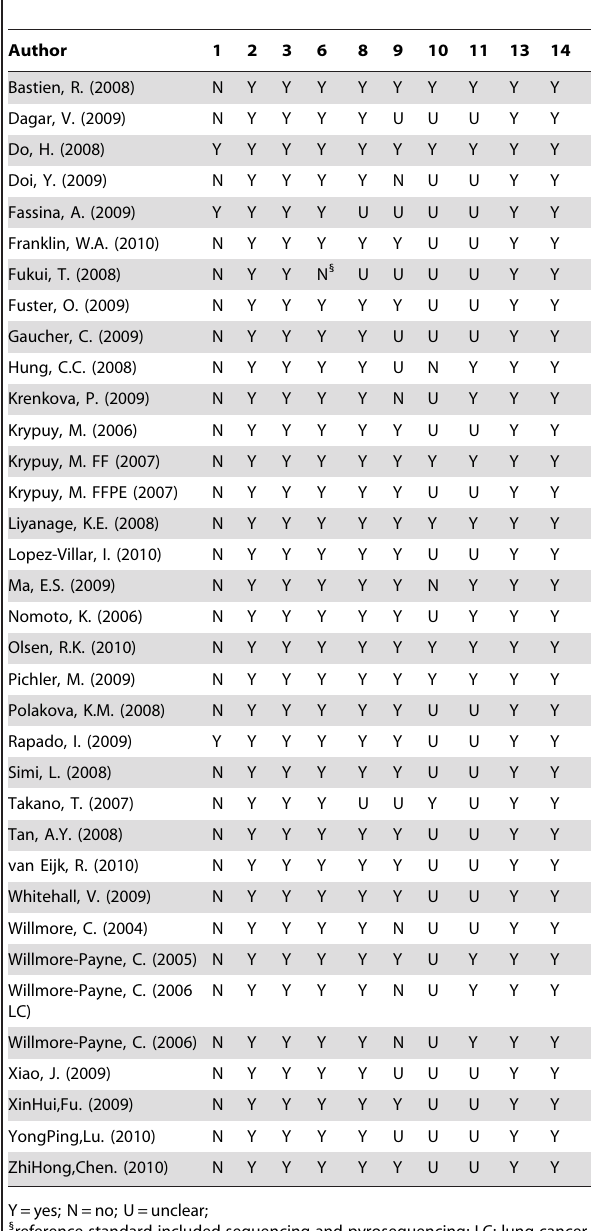
Table 1. ‘‘Quality Assessment of Diagnostic Accuracy Studies’’ (QUADAS) Tool.